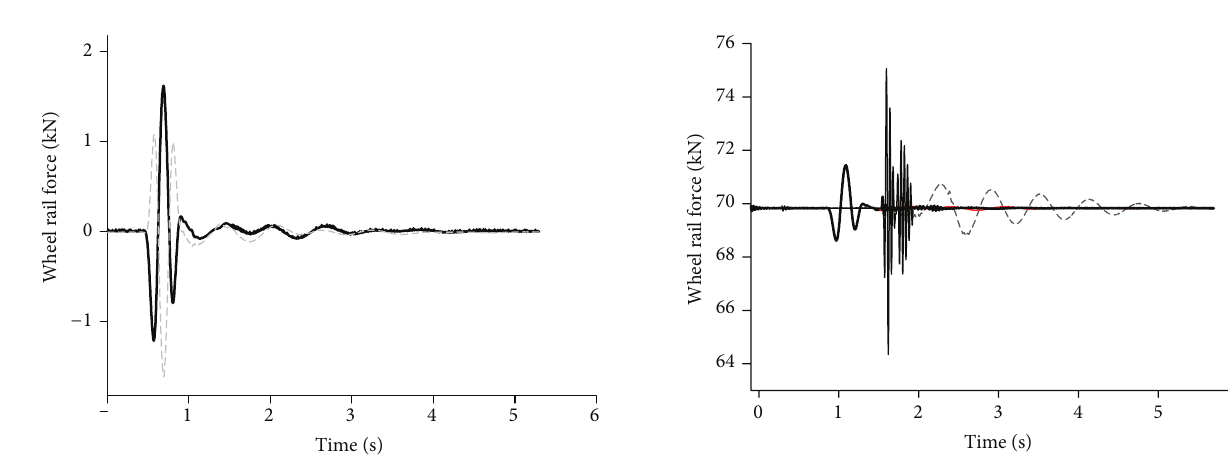
Figure 8: Vertical wheel/rail force (mean value is deducted). Bold line: vertical wheel/rail force of left side; dashed line: vertical wheel/rail force of right side.